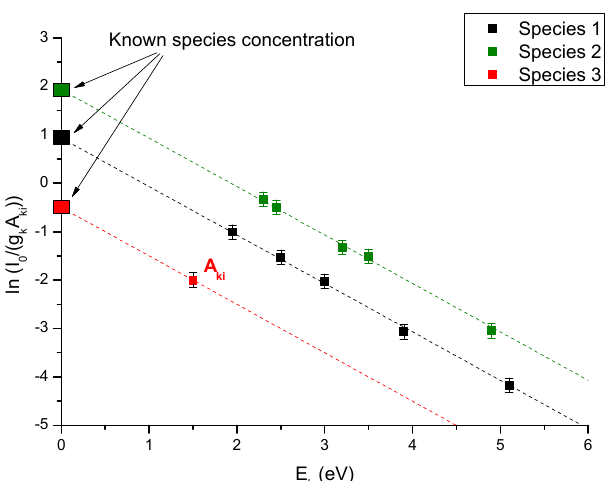
10 of 29 Figure 4. Determination of the unknown A ki of a spectral line from the Boltzmann plot of the same species.